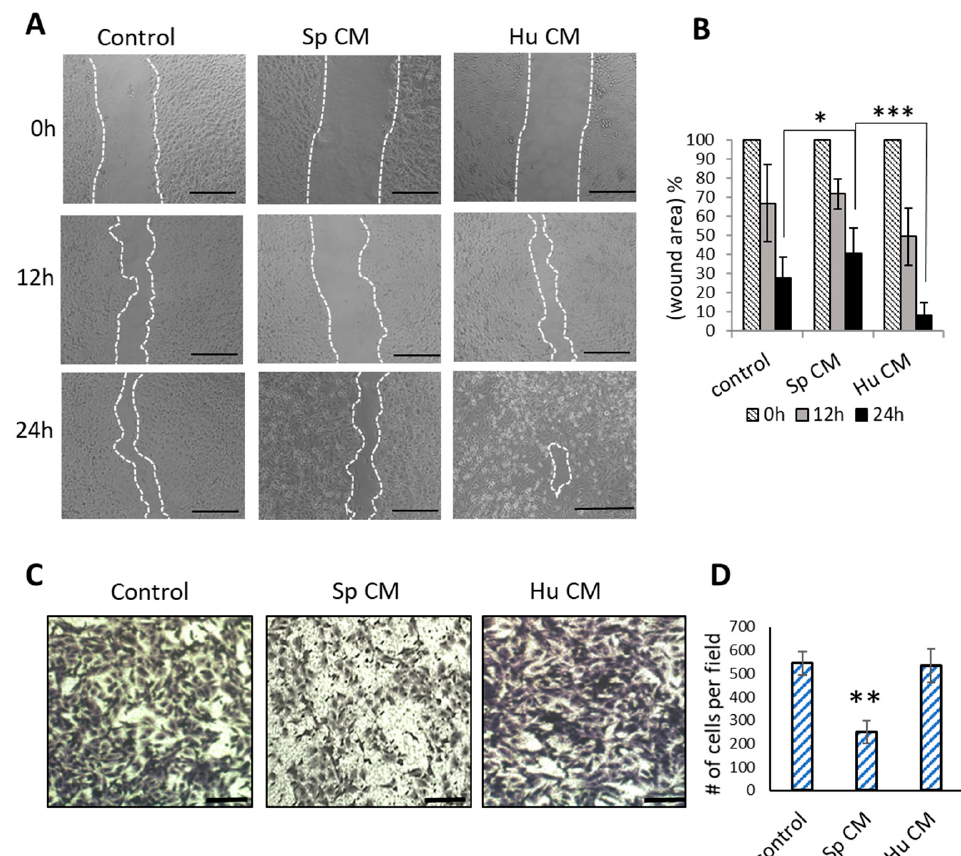
Figure 3. Effects of Spalax and human CMs on MDA-MB-231 migration (scratch assay and Transwell ® migration assays). ( A ) Representative images of wound healing in MDA-MB-231 cells treated with Spalax (Sp) and human (Hu) CMs. Cell monolayers were scratched with sterile pipette tip to form wounds. The scratch wounds were monitored after 12- and 24-h. Bars, 200 µ m ( B ) Percentages of cell free area were calculated and are presented as mean ± SD of three independent experiments (n = 3), * p ≤ 0.05 differences between wound area of Spalax CM and control at 24 h. *** p ≤ 0.05 differences between wound area of Spalax CM and human CM at 24 h ( C ) Transwell ® migration assays: CMs of Spalax and human fibroblasts were added to the lower chamber; suspension of MDA-MB231cells (1 × 10 5 ) in 500 µ L of RPMI were added to the upper chamber. Migrated MDA-MB-231 (adhered to the lower surface of the transwell membranes with an 8 µ m-pore size) were photographed after incubation for 24 h at 37 °C. Representative images are shown. Bars, 100 μ m ( D ) Migrated cells were calculated using ImageJ software in four independent view fields per insert. Experiments were performed in triplicates and repeated 3 times. Data are presented as mean ± SD (n = 3), ** p ≤ 0.001 differences between number of migrated MDA-MB-231 under effect of Spalax CM versus control. # means the number